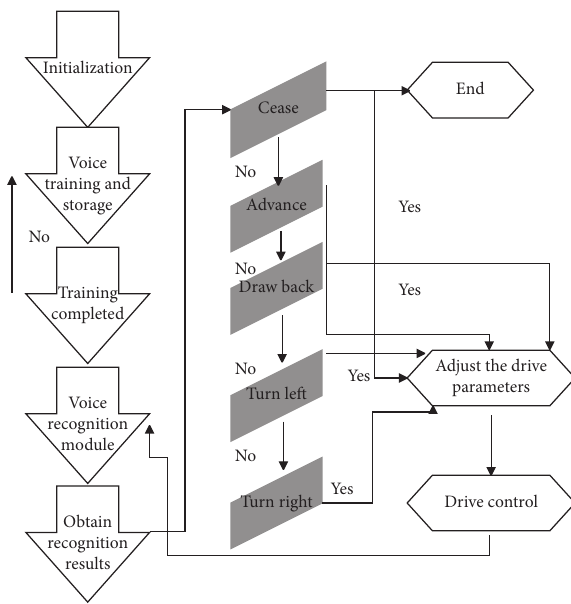
Figure 12: Realization process of system speech recognition control.